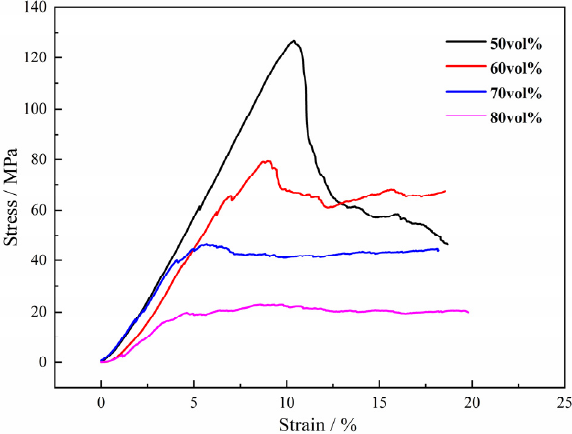
Figure 15 . Curves of engineering strain-stress of porous titanium with different volume fractions of the magnesium powders.